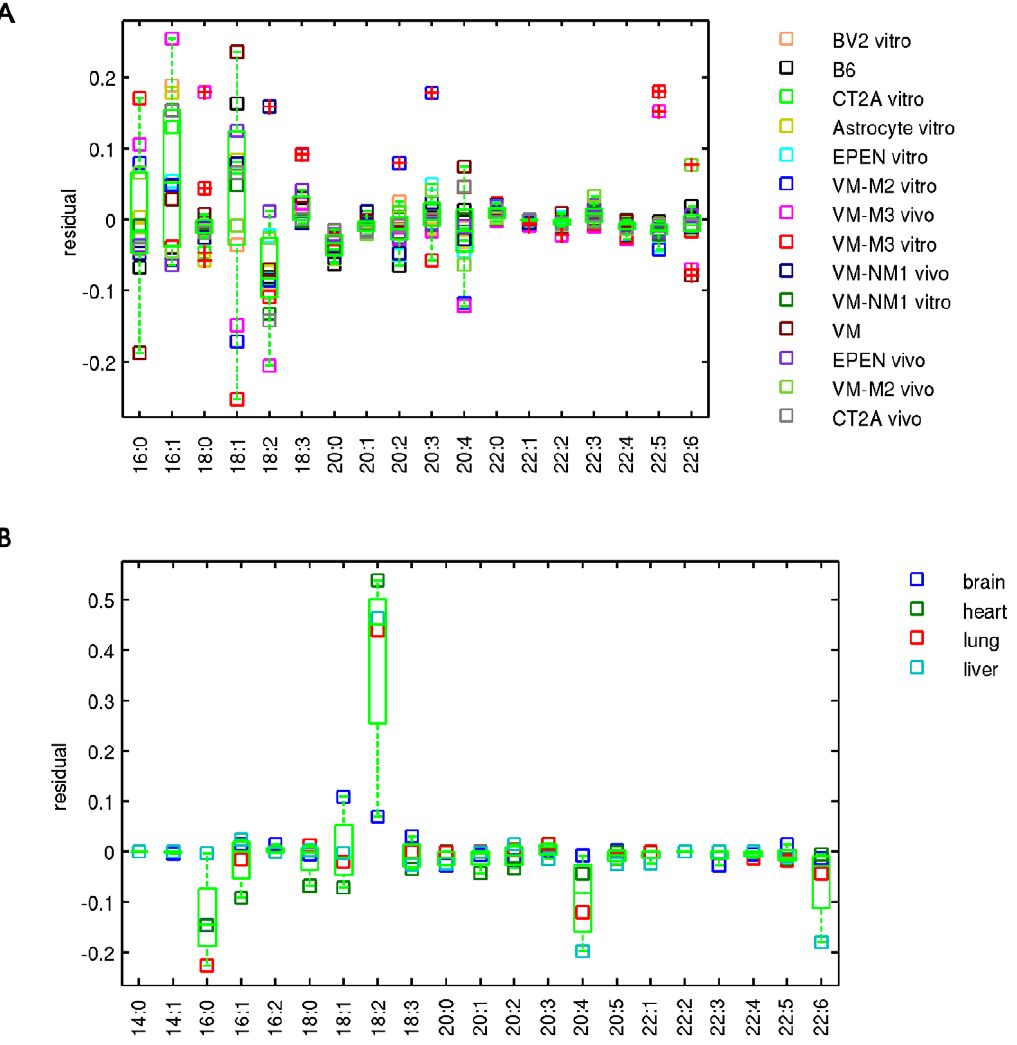
Figure 3. FA residuals reveal potential enzyme selectivity. The y-axis shows the residual between the FA composition best describing the CL data and the fit to this FA composition by the proportional incorporation model. A positive residual suggests enzyme preference. Box statistics are shown for 14 brain samples (A) and 4 B6 mouse tissues (B) with median and 25 th and 75 th percentiles.